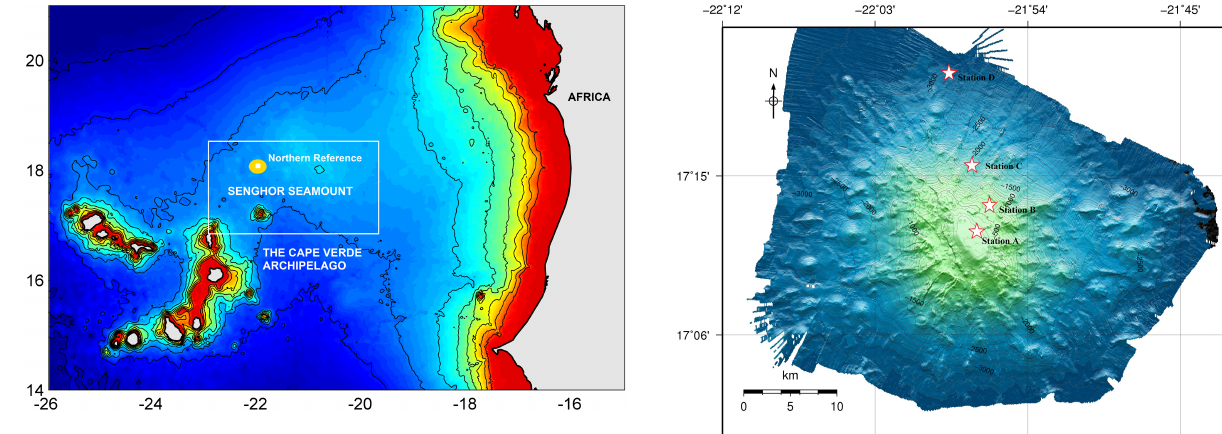
Fig. 1a. Senghor Seamount, located in the Cape Verde Archipelago, 60nm northeast of the island of Sal and ∼ 550km from the African mainland. Northern reference station also displayed. Data extracted from Smith and Sandwell (1997) dataset, created by A. Dale (SAMS).